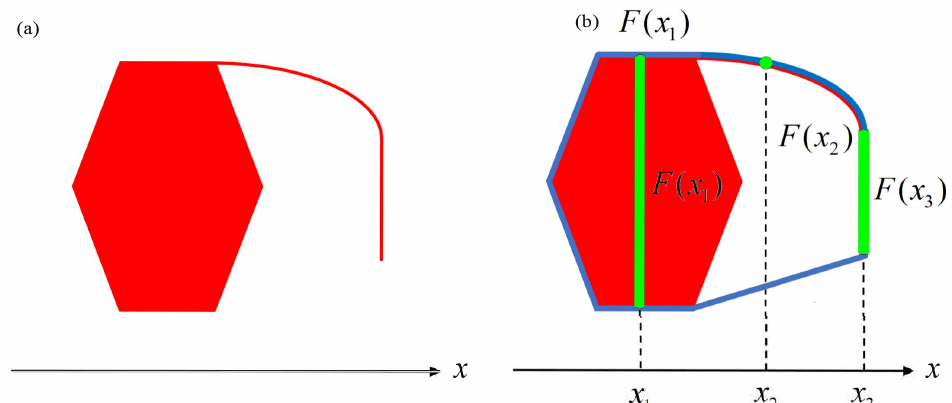
Figure 2. ( a ) Sketch of a set-valued function F ; ( b ) The convex hull of F (blue plot) and the values of F at points x 1 , x 2 and x 3